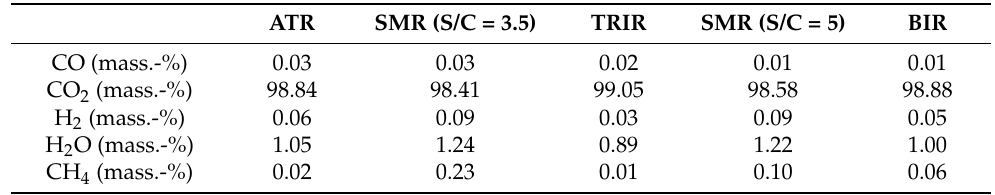
Table 11. Raw CO 2 out of Selexol process (p = 1.95 bar).